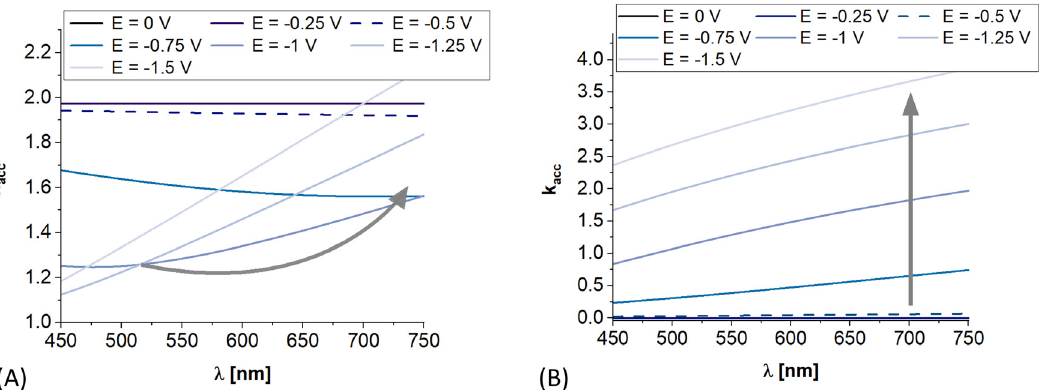
Figure3: E -inducedevolutionofanaveraged(A)refractiveindexand(B)extinctioncoef fi cientintheaccumulationlayer.Theresultsareshown for N reaching of 3e19 cm − 3 where accumulation layer of ∼ 20 nm appears for E < − 0.5 V (see